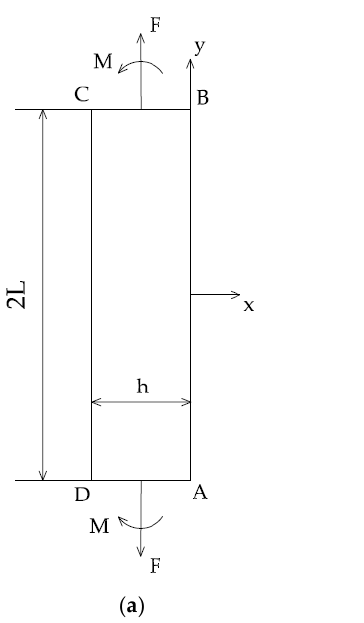
Figure 1. Schematic diagram of the process: ( a ) initial configuration; and ( b ) intermediate and final configurations.